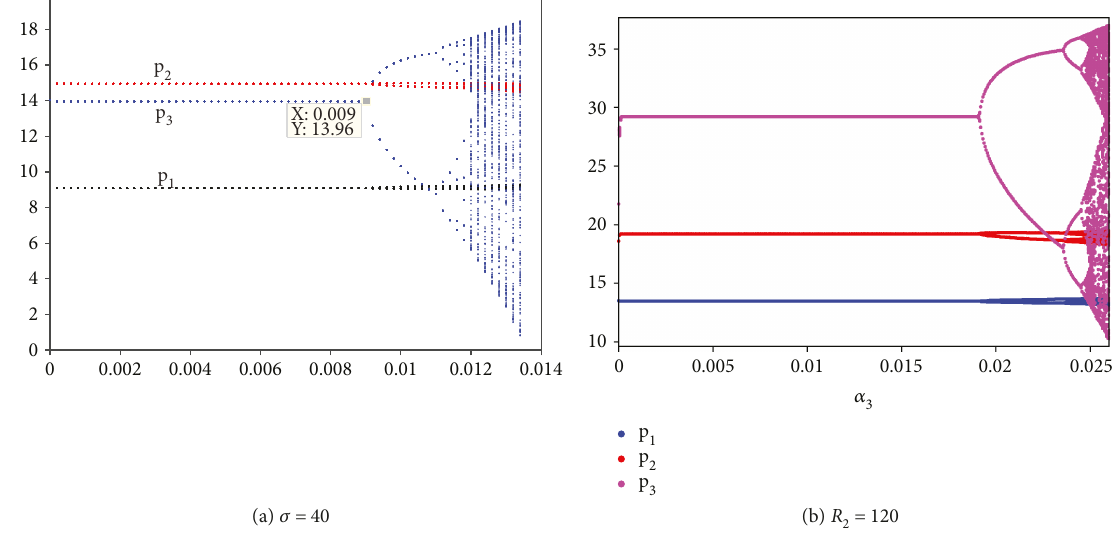
Figure 4: The evolution process of system (12) with di ff erent parameter